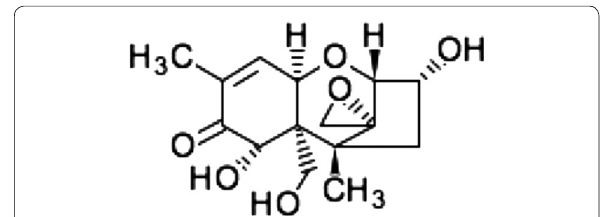
Fig. 1 Chemical structure of deoxynivalenol